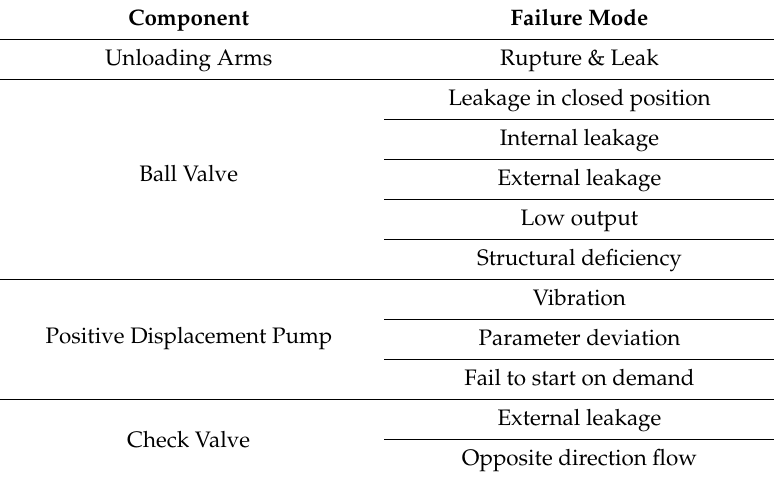
Table 4. Unloading system component failure modes.